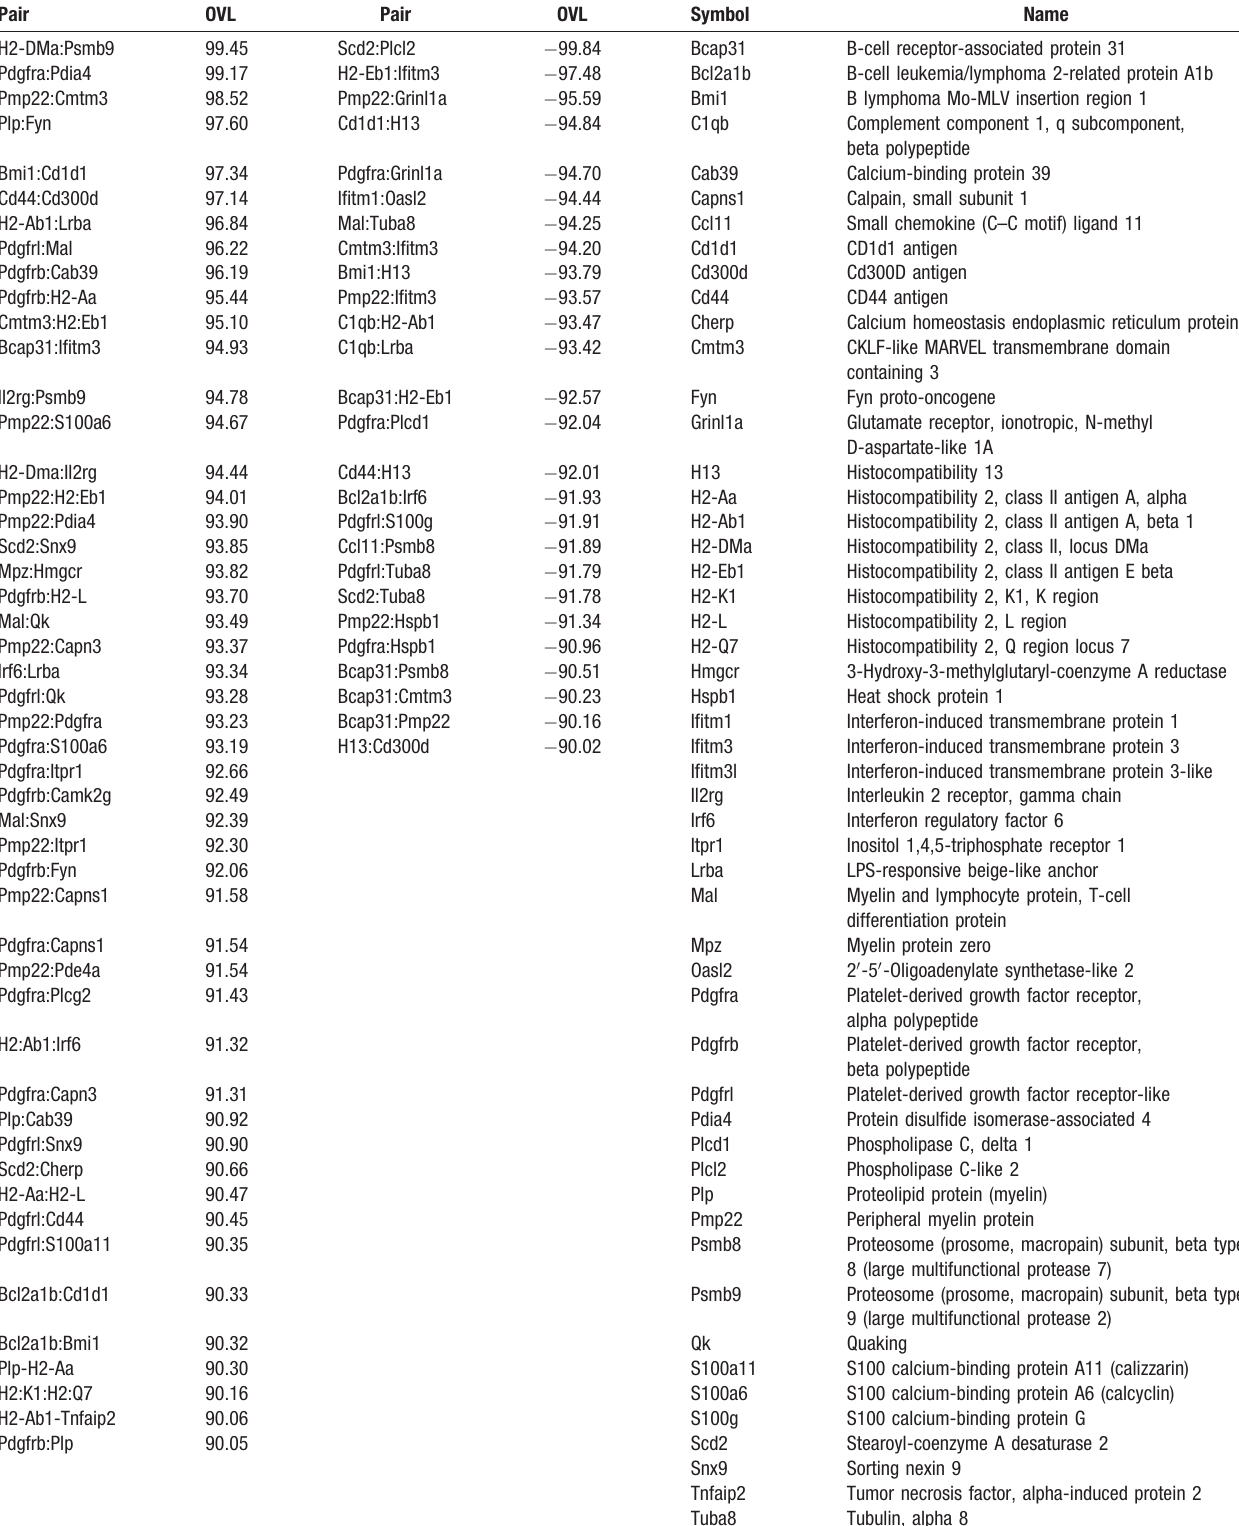
Table 7. The most like (OVL > 90) and opposite (OVL < (cid:2) 90) see-saw partners among genes involved in myelination (MYE), calcium signaling (CAS), and immune response (IRS) in spinal cord of adult control female